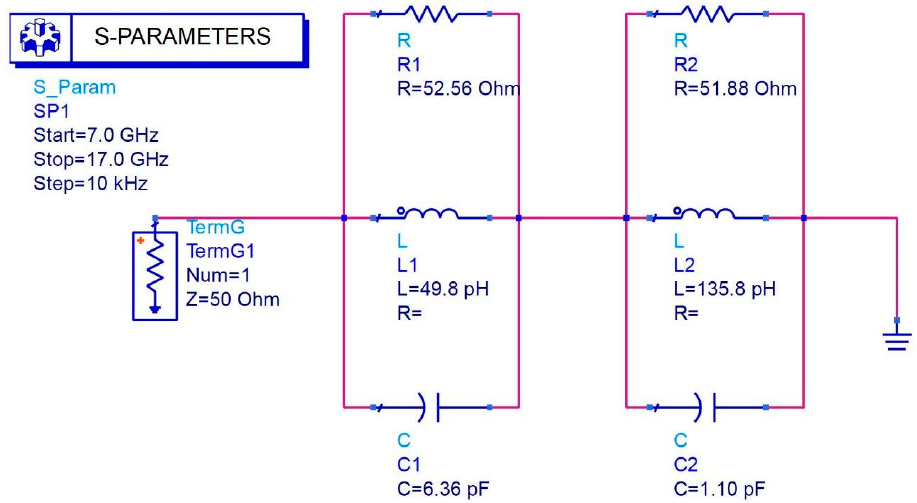
Figure 8. Circuit diagram of a parallel RLC circuit for resonant frequency (refer to CST simulation) using ADS Agilent simulation.